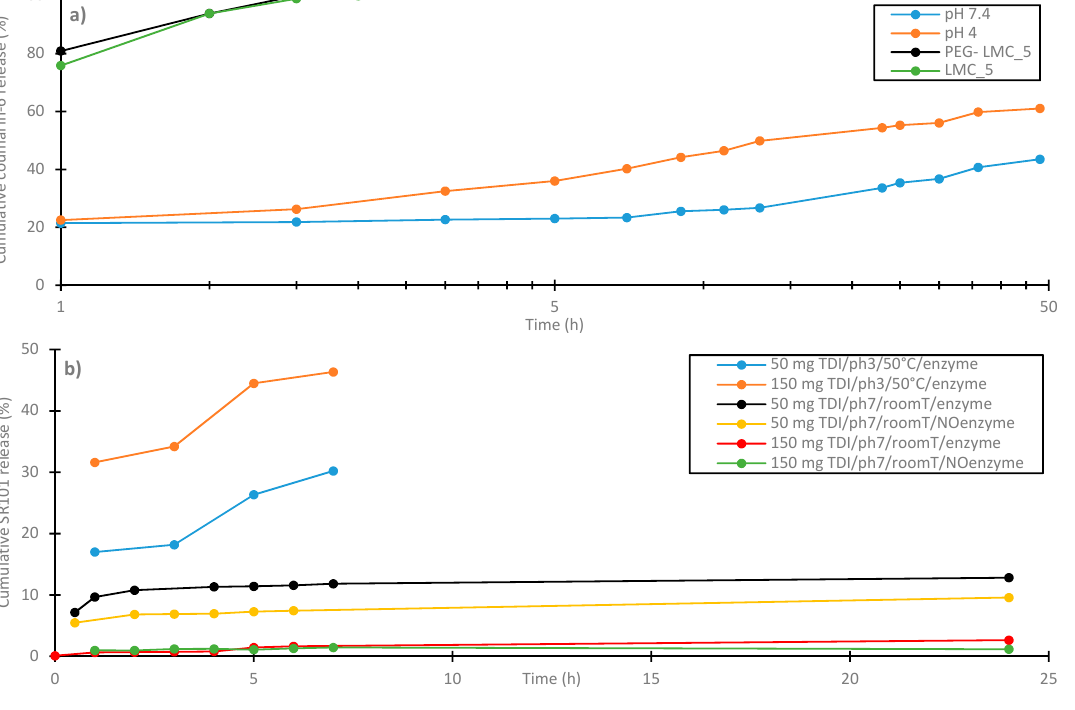
Figure 9. Releasing rates of hydrophobic Coumarin-6 and hydrophilic SR101 for different lignin capsules. ( a ) Coumanrin-6 releasing rate of capsules produced by Chen et al. [126] at pH 4 and pH 7.4 (Adapted with permission from [126]. Copyright 2016 American Chemical Society) and capsules (PEG-LMC_5 and LMC_5) produced by Tortora et al. [125] (Adapted with permission from [125]. Copyright 2014 American Chemical Society); ( b ) SR101 releasing rate at different amounts of crosslinking agent TDI, pH values, temperatures and degradation by enzymes [124], published by The Royal Society of Chemistry.